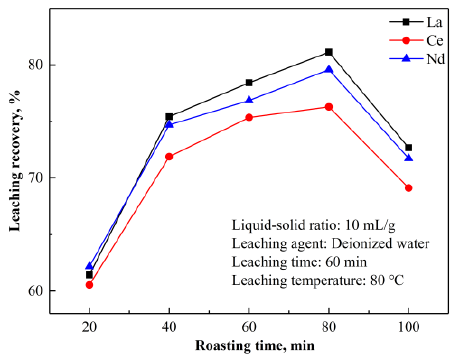
Figure 17. Effect of (NH 4 ) 2 SO 4 activation roasting time on the leaching recoveries of La, Ce, and Nd.